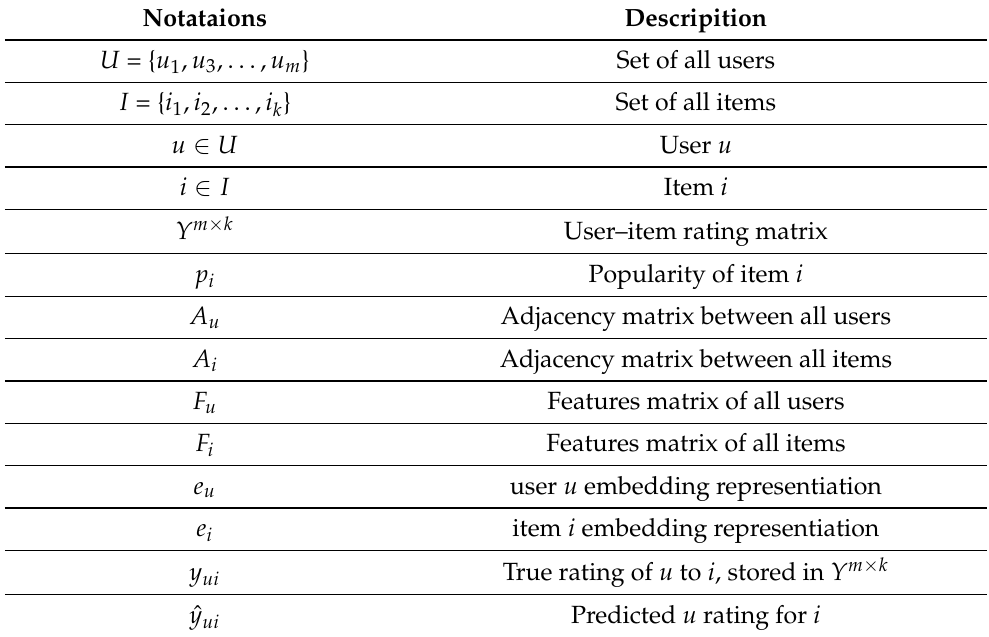
Table 1. Summary of terminologies used.